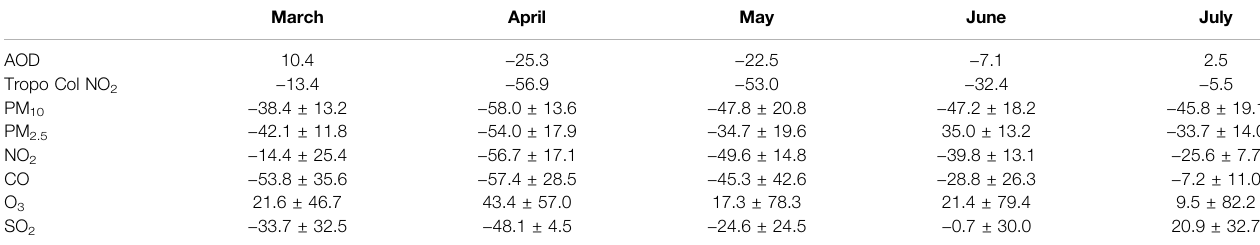
TABLE 5 | Average combined percentage change for all the stations considered here as representative for changes in Delhi in monthly mean concentrations of various species during COVID-19 months with respect to average of 2015 –